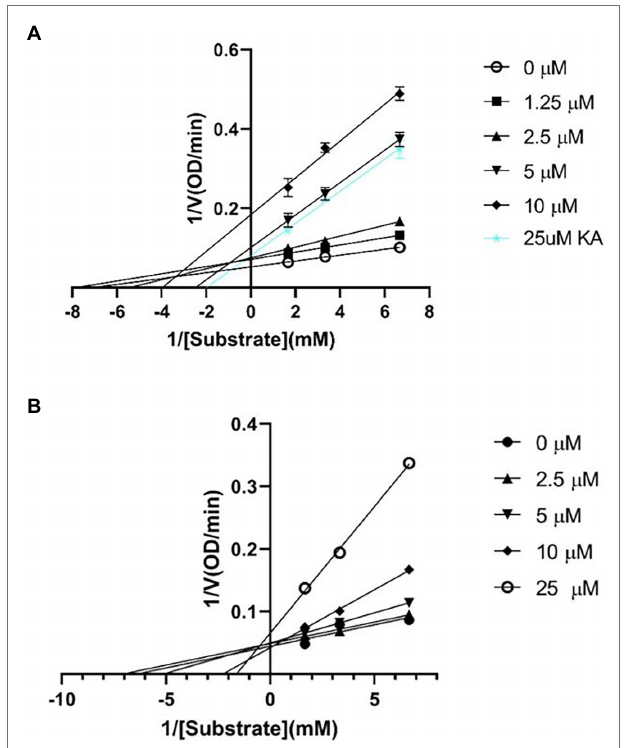
FIGURE 6 | Lineweaver-Burk plots for inhibition against mushroom tyrosinase of (A) ScyM ( 1 ), and (B) KA ( 3 ). The blue line in (A) represents KA at 25 μ M, which was used as the positive control in the assay. Experiments were carried in triplicate and error bars represent standard